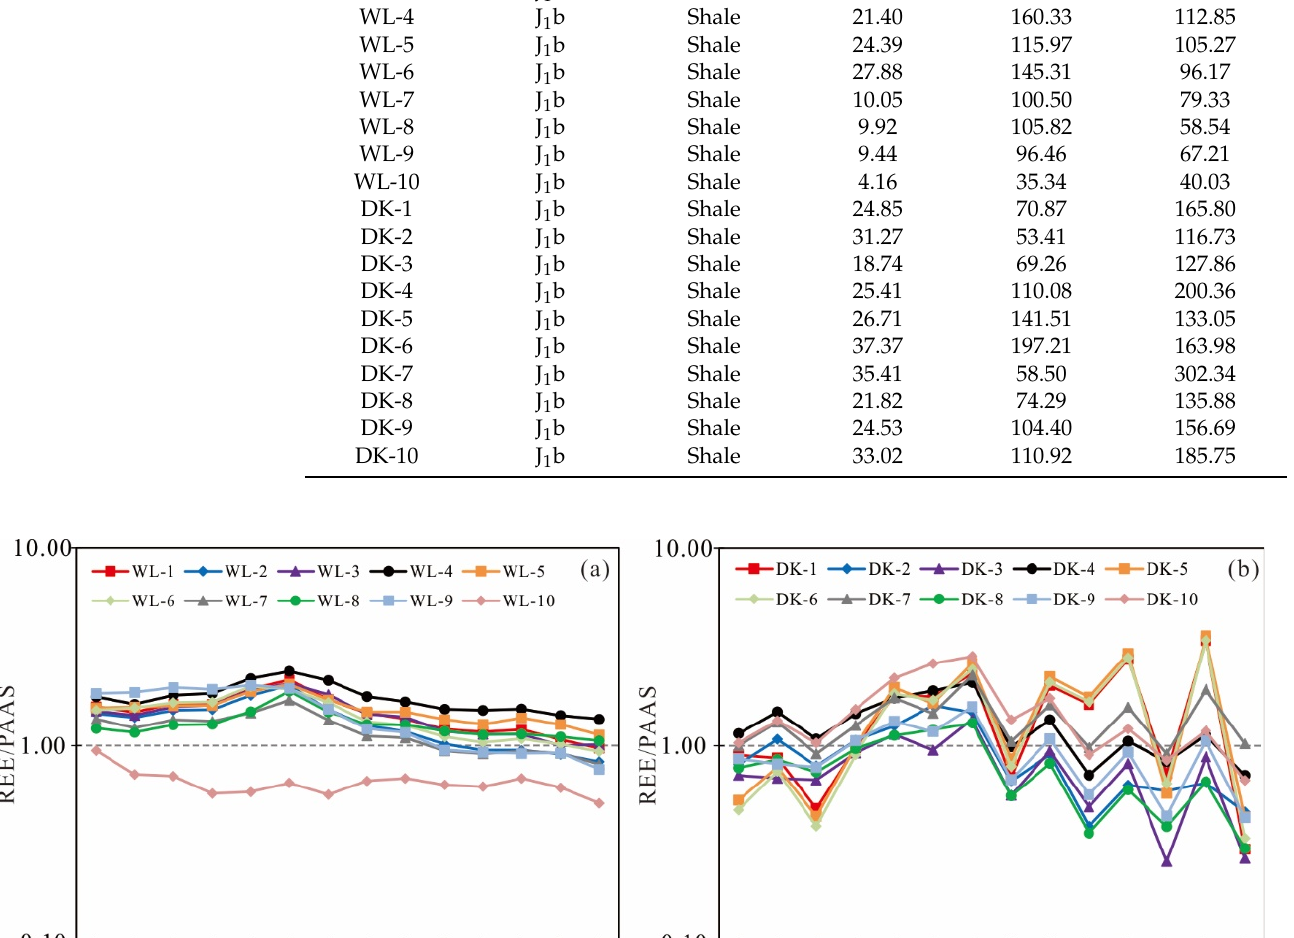
Figure 5. Distribution pattern of rare earth elements in the ( a ) WL samples and ( b ) DK samples.